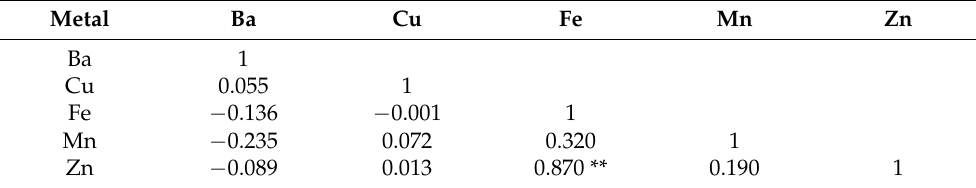
Table 4. Correlation matrix for the heavy metal concentration of groundwater samples.